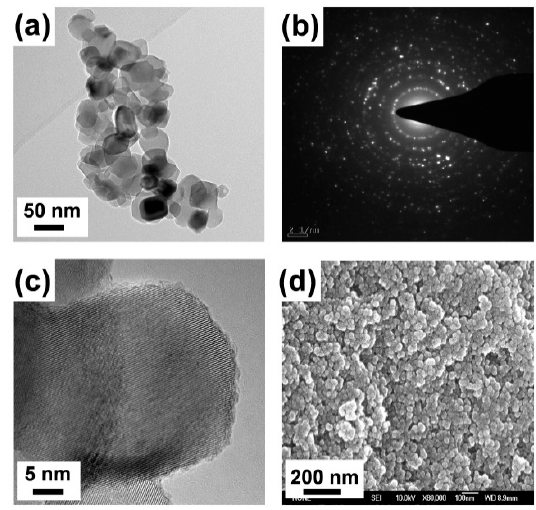
Figure 5. ( a , c ) High-resolution transmission electron microscopy (HRTEM) image of ANT800 NPs. ( b ) Selected area diffraction pattern (SAED) of ANT800 NPs. ( d ) Field emission scanning electron microscope (FESEM) image of ANT800 NPs.